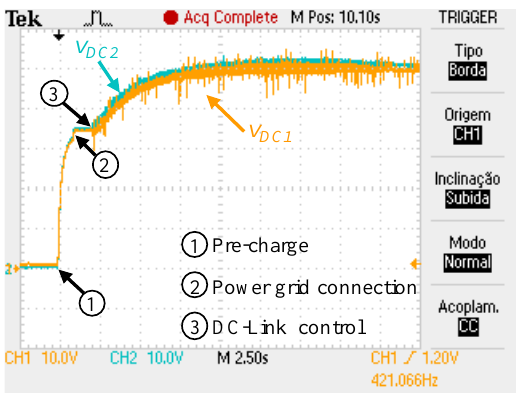
Figure 26. Experimental validation of the DC-link voltages ( v DC 1 and v DC 2 ) control algorithm.